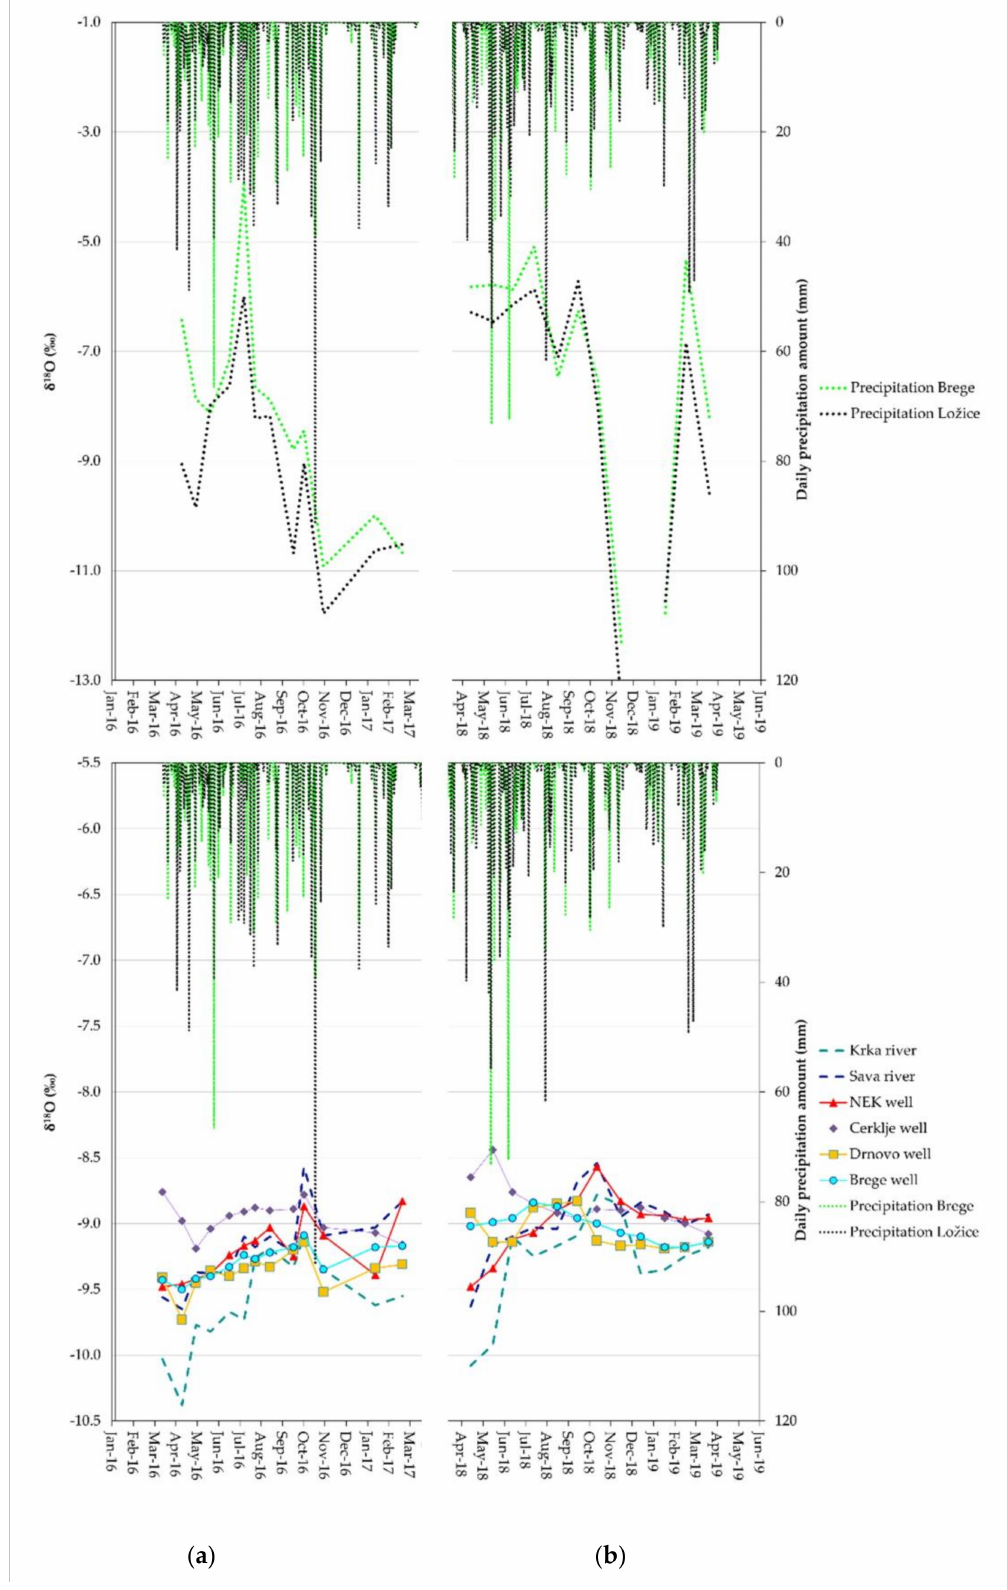
Figure 3. Oscillation of δ 18 O in water samples in the catchment area of the Krško field and Vrbina aquifer ( a ) before and ( b ) after the filling of the accumulation basin for the HPP Brežice in relation to the daily amount of precipitation in Brege and Puste